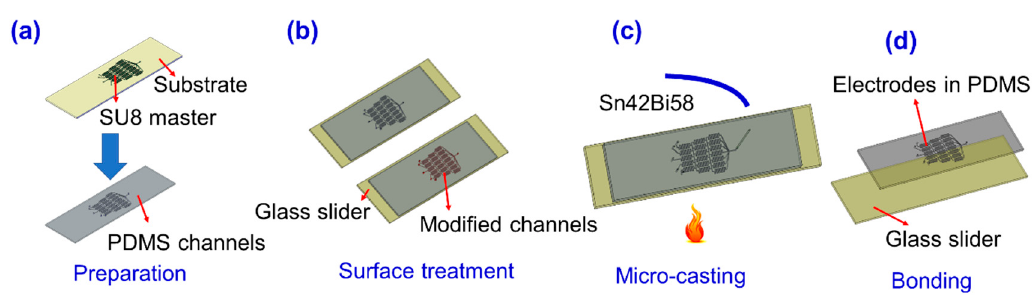
Figure 1. The procedures to fabricate the high height–width ratio electrodes. ( a ) Preparation of PDMS microfluidic channels. A SU8 mold was firstly lithographed, and then a PDMS layer with a patterned channel was peeled off as the mold for the micro electrodes. ( b ) surface treatment of inner walls of the microfluidic channel walls. ( c ) reversable bonding of the PDMS channel with a glass slider; melting and micro-casting within the microchannels. ( d ) In-reversable bonding of the metal-in-PDMS electrode and glass slider.